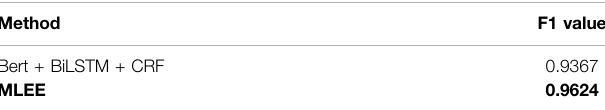
TABLE 4 | Comparison of MLEE information extraction and traditional sequence